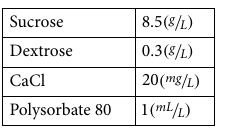
Table 1. DEP buffer